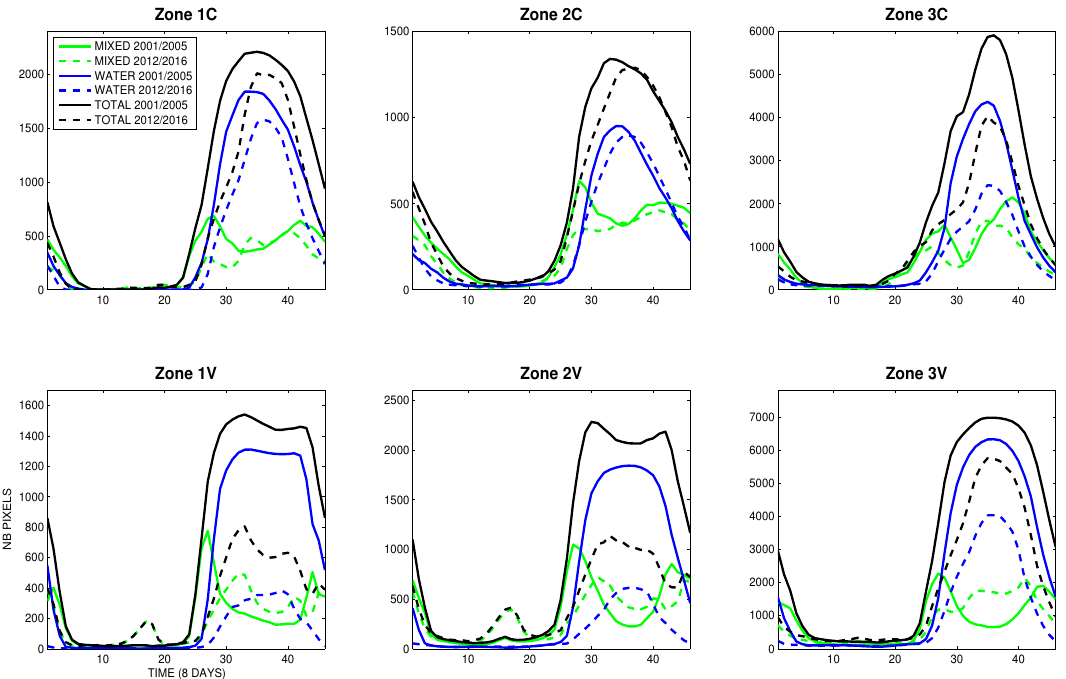
Figure 8. Season of the mixed (green), water (blue), and total (black) seasons for years 2001–2005 (continuous line) and years 2012–2016 (dashed line). These seasons are represented over the three zones in Cambodia ( top row : 1C, 2C, 3C) and over the three zones in Vietnam ( bottom row : 1V, 2V,